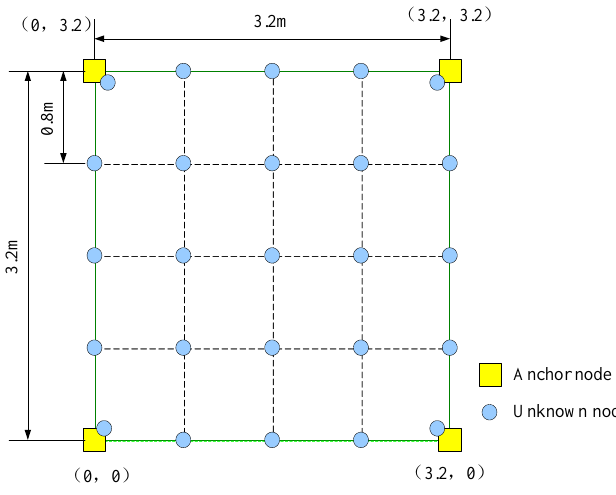
Figure 8. The deployment of the distance estimation